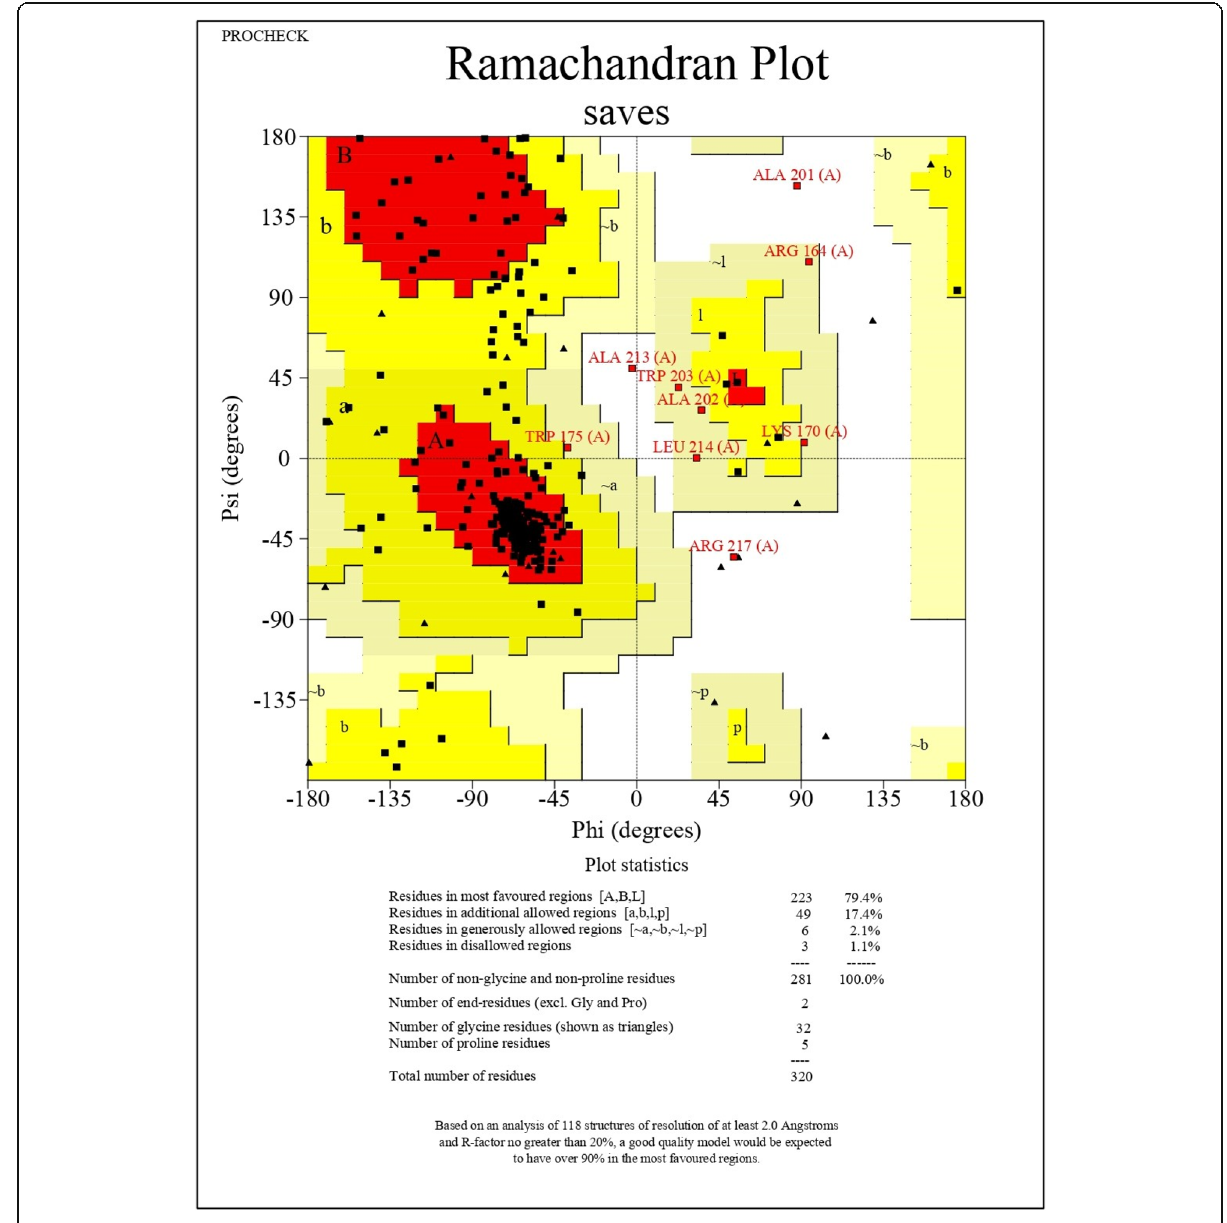
Fig. 5 Ramachandran plot for a full-fledged vaccine against canine